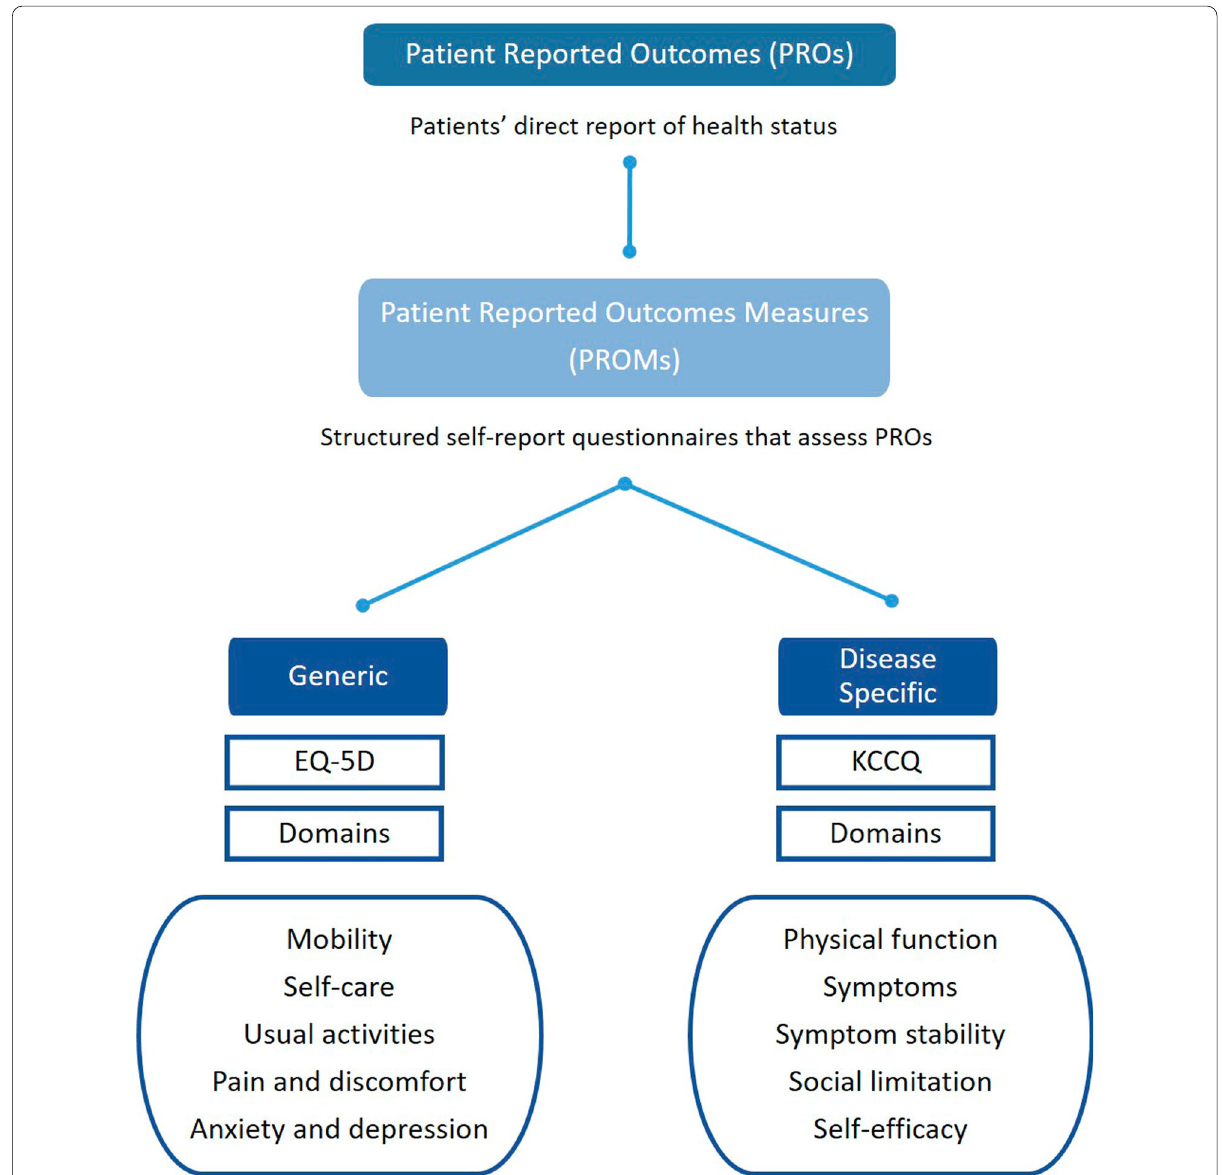
Fig. 1 This figure describes PRO’s and PROMs’ definitions and the two categories of